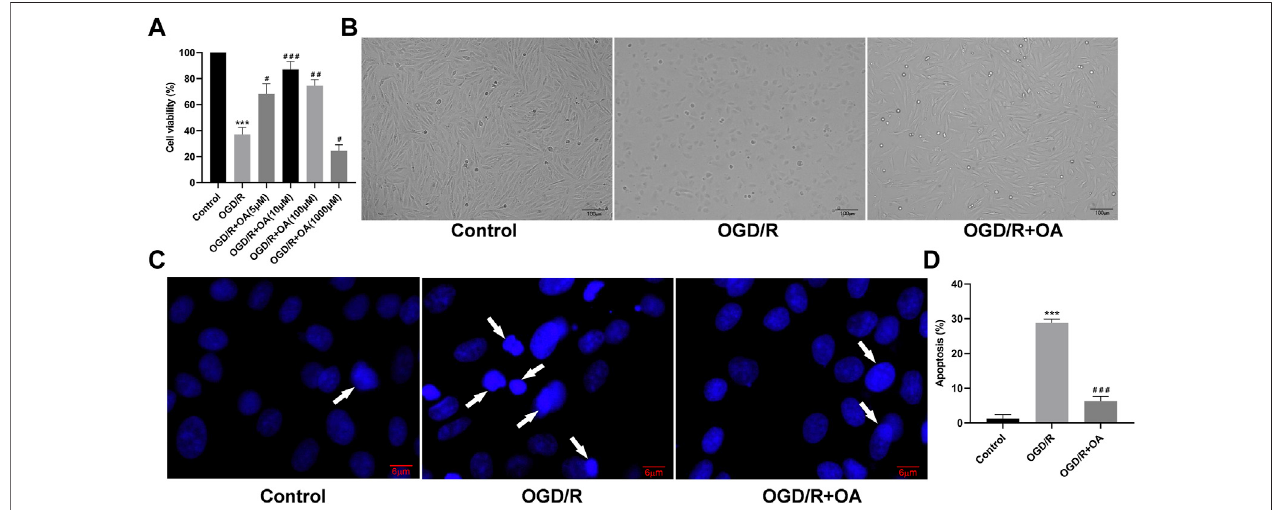
FIGURE3| OAtreatmentattenuatesOGD/RinducedH9c2cellsinjury (A) CellviabilityoftheOGD/R+OAgroupwasthehighestcomparedwiththeOGD/Rgroup at a dose of 10 μ M. When the concentration was higher than 10 μ M, the cell viability gradually decreased (B) Representative images of H9c2 cells morphological changesineachgroup(scalebar=100 μ m) (C,D) RepresentativeHoechst33,258imagesandquantitative analysisofapoptoticratioforH9c2cellsineachgroup(scale bar = 6 μ m). Arrows indicate representative apoptotic positive cells. Data are presented as the mean ± SD. ppp p < 0.001, compared with the Control group; # p < 0.05, ## p < 0.01, and ### p < 0.001, compared with the OGD/R group. OGD/R: oxygen-glucose deprivation/reperfusion; OA: Oroxin